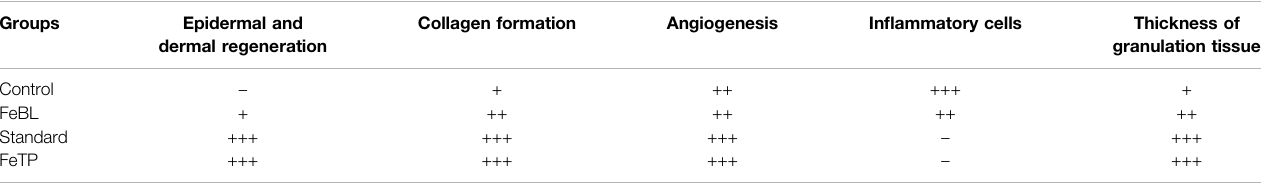
TABLE 2 | Histological data of the granulation tissue obtained from different groups. Groups